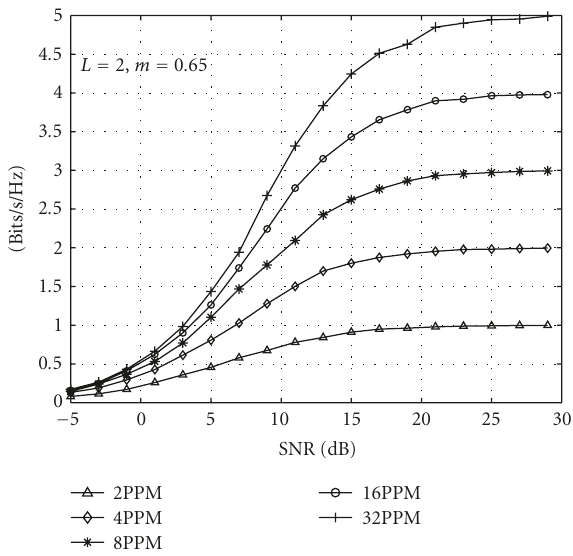
Figure 3: Capacity of a UWB system with PPM over a multipath fading channel with L = 2 and m = 0 . 65.